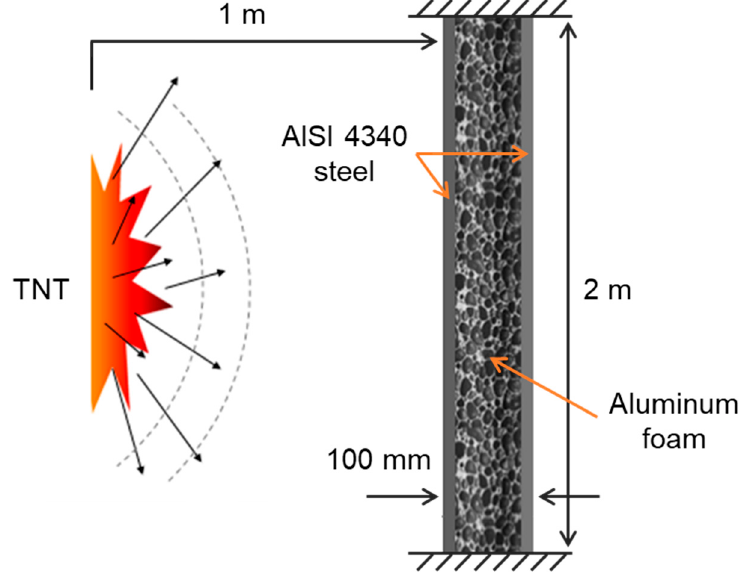
Figure 5. Aluminum foam-cored sandwich panels subjected to blast impact [9].